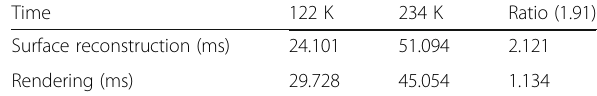
Table 1 The time relation of surface reconstruction, rendering in different number of particles Time Surface reconstruction